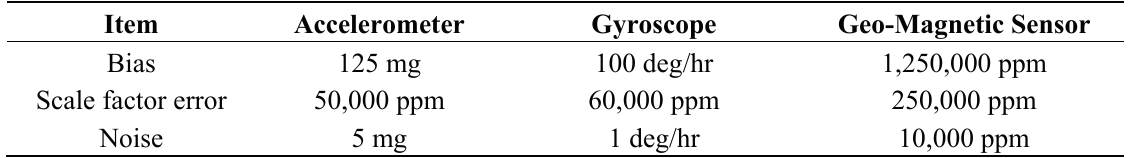
Table 2. Major parameters for sensor